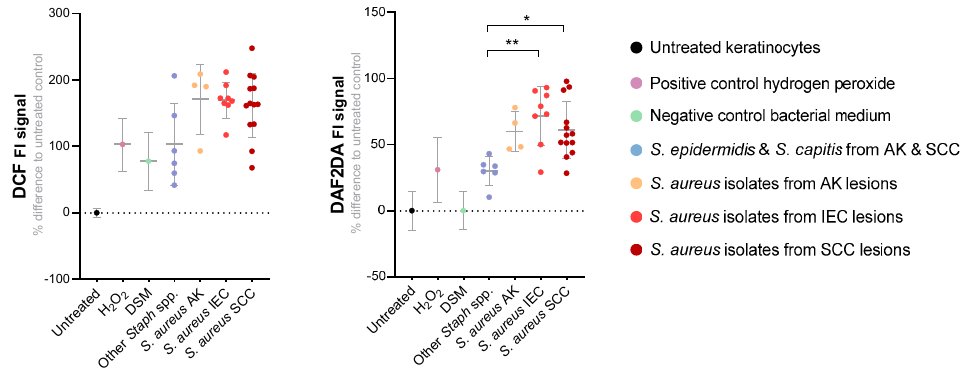
Figure 4. Exposure to S. aureus secretome increases intracellular reactive oxygen and nitrosative species in human keratinocytes. The level of intracellular reactive oxygen/nitrogen species after 6 h treatment with secretome from S. aureus isolated from actinic keratosis (AK, n = 4), intraepithelial carcinoma (IEC, n = 8) or squamous cell carcinoma (SCC, n = 13), was measured in primary human keratinocytes using three different fluorescent probes. The positive control was hydrogen peroxide (H 2 O 2 ) and negative controls included untreated cells, S. aureus culture media (DSM) and secretome from other Staphylococcus species derived from AK and SCC ( S. epidermidis , S. capitis ). Displayed is the relative fluorescent signal (as percentage difference from the untreated control) for the TotalROX probe measuring peroxyacids, free radicals, singlet oxygen and nitrosative species, DCF-DA probe measuring hydroxyl and peroxyl radicals and DAF-2 DA probe, a nitric oxide indicator. Each dot represents a different bacterial isolate and shows the grouped mean value from three independent experiments, each performed in technical triplicates. Dunn’s multiple comparisons test was performed between groups S. aureus AK, IEC, SCC and other Staphylococcus spp. for each assay (* p < 0.05; ** p < 0.01).